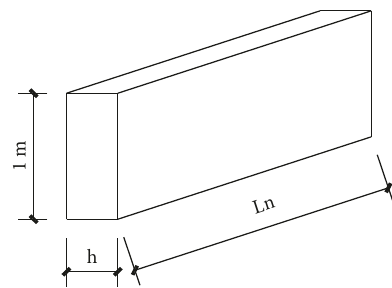
Figure 1: Research object of the model: 1 m-long strip of the pool